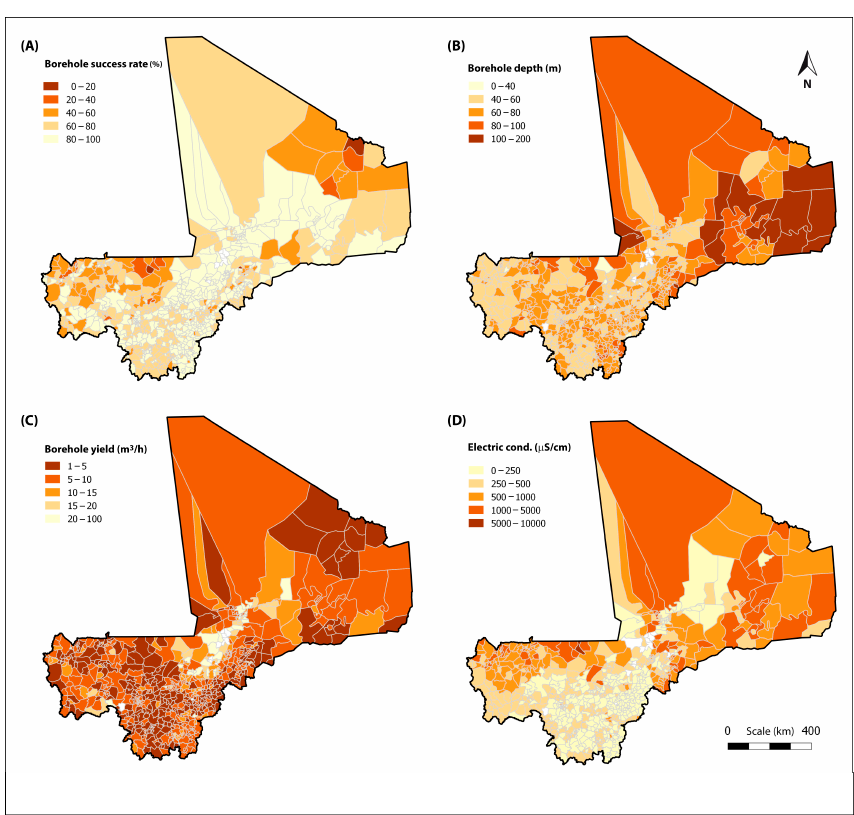
Figure 6. Spatial distribution of the key borehole variables at the commune scale. ( A ) Borehole success rate (%). ( B ) Arithmetic mean of borehole depth (m). ( C ) Arithmetic mean of borehole yield (m 3 /h). ( D ) Arithmetic mean of electrical conductivity ( μ S/cm).